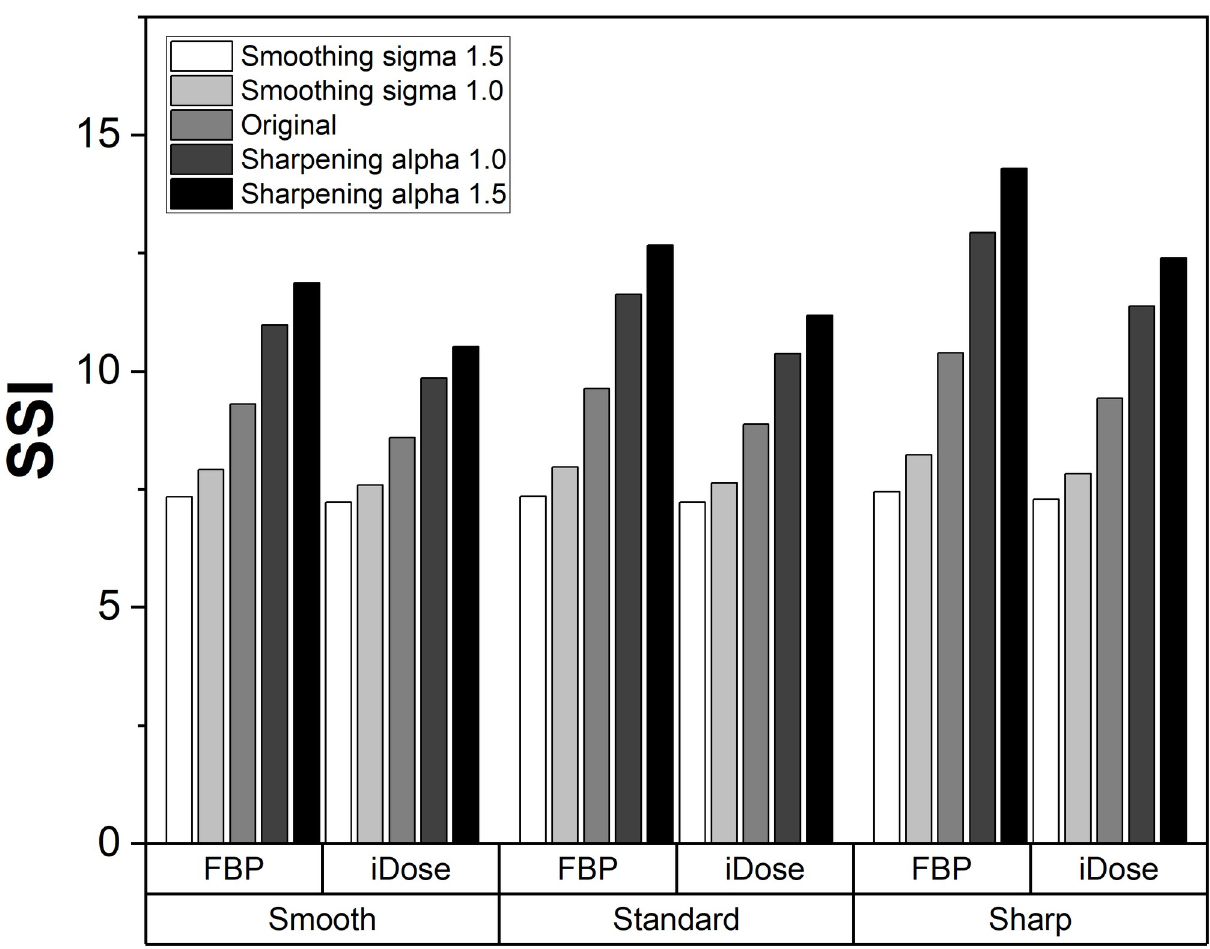
Fig 7. SSI comparison acquired at a triple modality 3D abdominal phantom data. The data included reconstructions with smooth, standard, and sharp kernel along with two kinds of reconstruction methods (FBP and IR). The images with artificially manufactured of smoothing and sharpening were